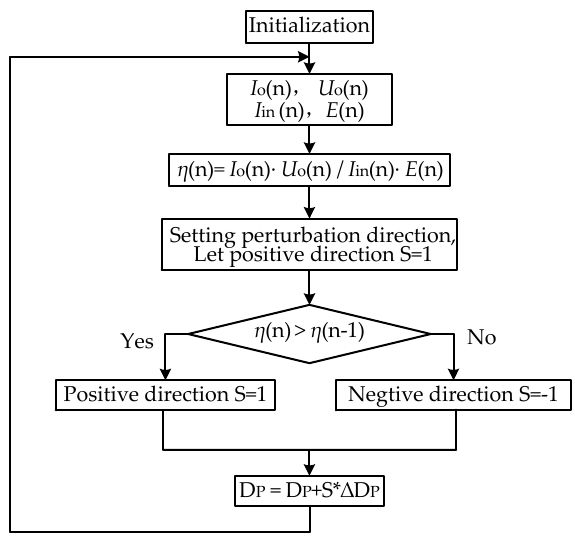
Figure 9. Flow chart of the MEPT control.